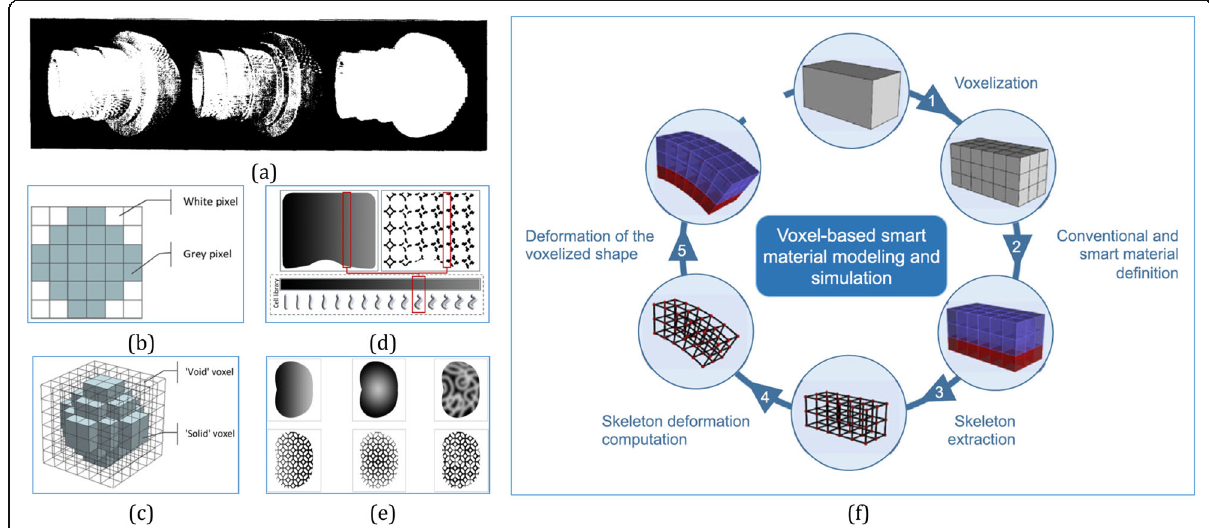
Fig. 2 a Object voxelized along the slicing direction based on three different resolutions [31]; A voxel-based method of constructing and skinning functionally graded lattice structures suitable for AM [32]: pixel image of a circle with a low resolution ( b ); voxel model of a sphere with a low resolution ( c ); a domain with functionally grading gradients ( d ); functionally graded structures generated from input gradients ( e ). f The conceptual design framework for 4D printing [33]